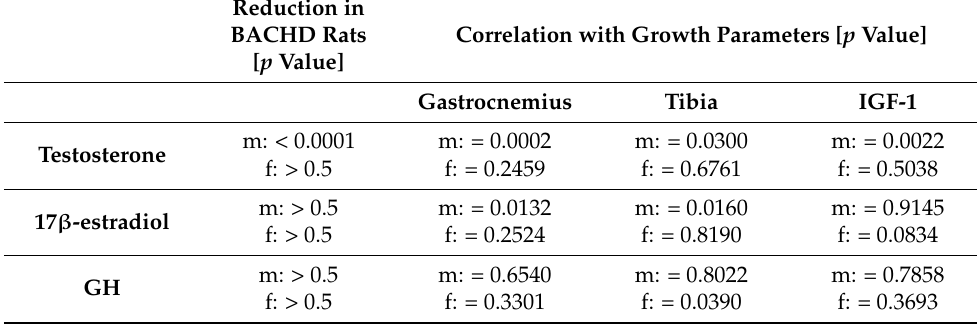
Table 1. Hormone level reductions and their correlations to growth parameters in male (m) and female (f) BACHD rats. Reduction